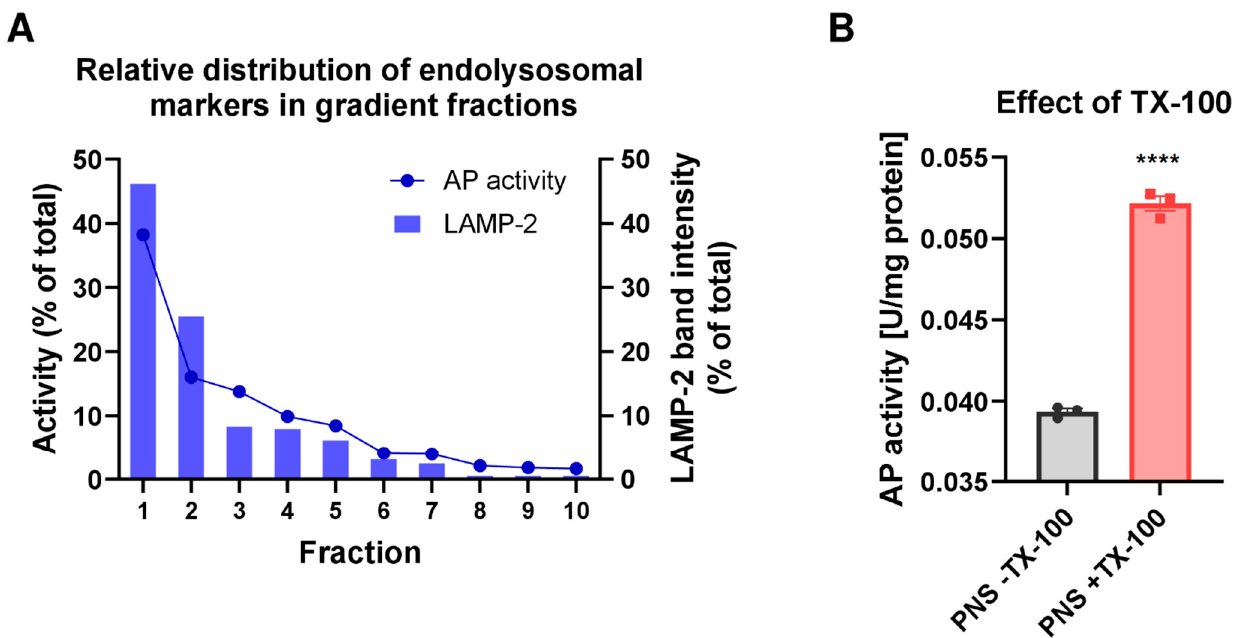
Figure 2. The activity of the luminal endolysosomal enzyme acid phosphatase in the gradient fractions in comparison to LAMP-2 distribution. ( A ) The activity of the luminal endolysosomal enzyme acid phosphatase (AP) was assessed in density gradient fractions to further define endolysosome-enriched fractions. AP activity in the gradient fractions was measured after endolysosomal membrane lysis with Triton X-100 (TX-100) and calculated in units (U) per mL. For each fraction, the percentage of total activity in all fractions combined (set to 100%) is plotted in comparison to the percentage of total recovered LAMP-2 in all fractions. The total LAMP-2 amount in each fraction was obtained by calculating the product of band intensity/ µ g total protein and total protein amount in the fraction. A peak for the relative AP activity as well as the endolysosomal marker protein LAMP-2 was detected in F1, indicating that the bulk of endolysosomes was contained in this fraction. Data were collected from one representative gradient. ( B ) Diagram showing the effect of TX-100 treatment on measured AP activity. The increase in AP activity after the addition of TX-100 to the post-nuclear supernatant (PNS) reflects the efficiency of organelle lysis and the structural integrity of organelles present in the PNS loaded onto the gradient. AP activity is presented in U/mg of protein. Data are shown as individual values and the median of three replicates. The significance of the difference is indicated by asterisks (**** p < 0.00001).